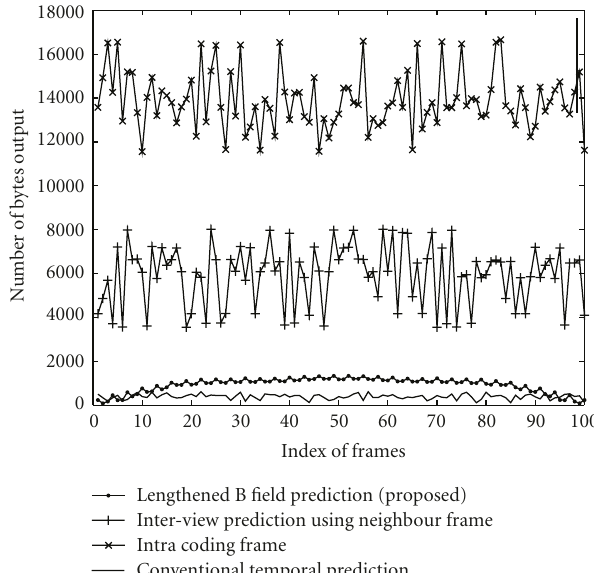
Figure 14: Comparison of the compression e ffi ciencies for room